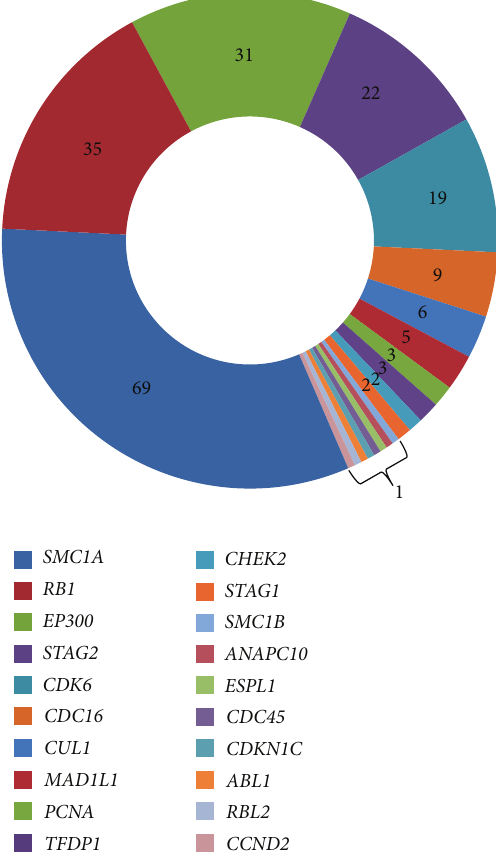
Figure 1: Distribution of genomic CNVs (numbers correspond to amount of individuals demonstrating CNV affecting a gene) across genes implicated in the cell cycle pathway